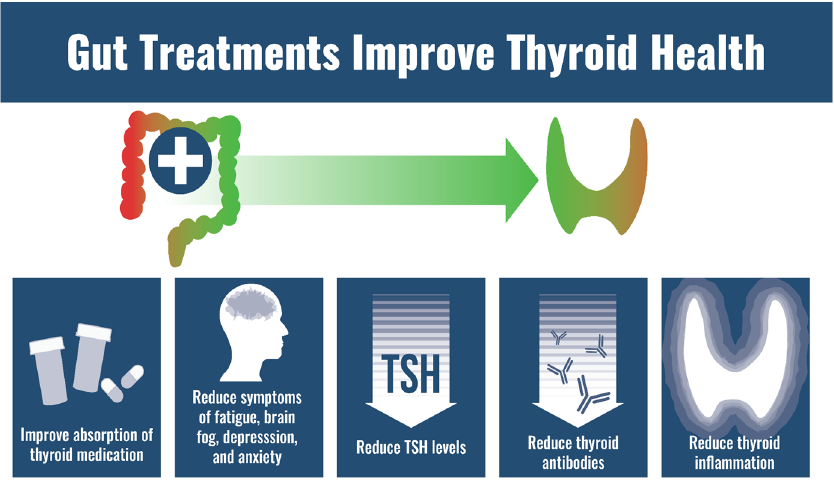
Figure 3. GI effects of GI care on thyroid